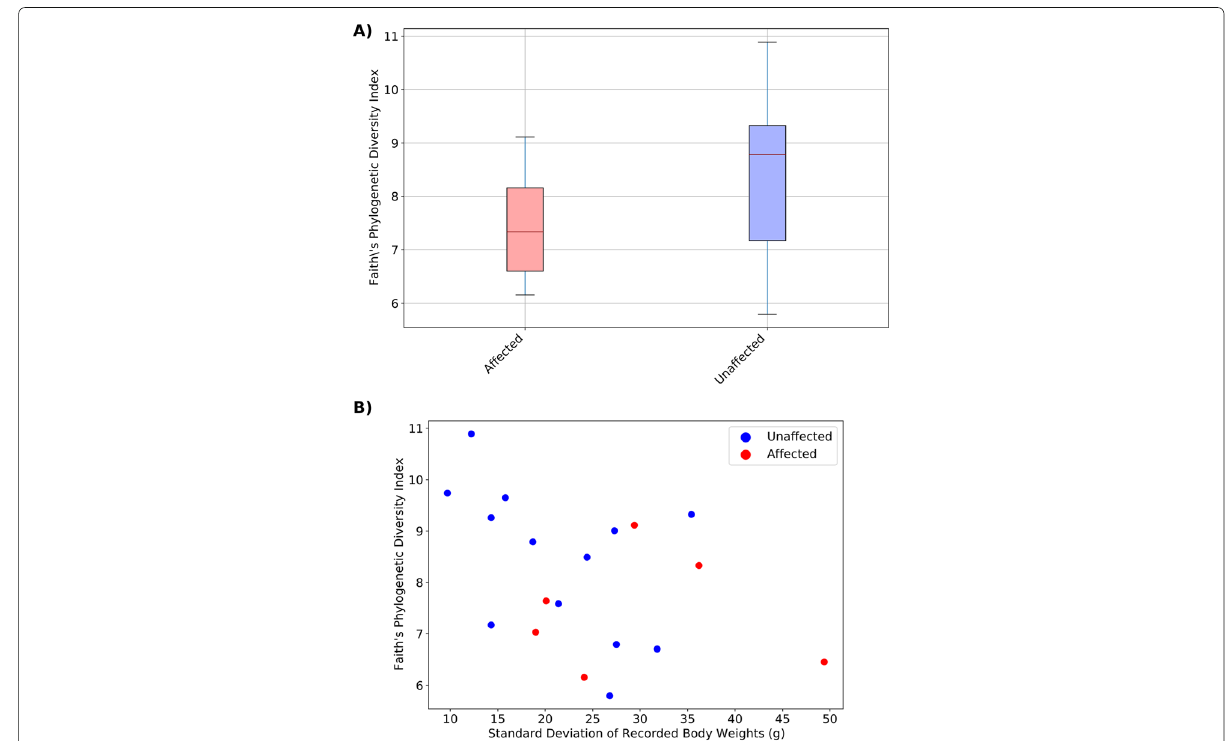
Fig. 1 Alpha diversity. Affected animals had a higher species richness ( a ) than unaffected animals (Affected: mean = 7.45, SD = 1.13; Unaffected: mean = 8.40, SD = 1.47) although this difference was not significant (H = 1.97, p = 0.16). Species richness was negatively correlated with standard differentiation between recorded body weights ( b ) although the result was not significant (R = -0.44, p = 0.06)